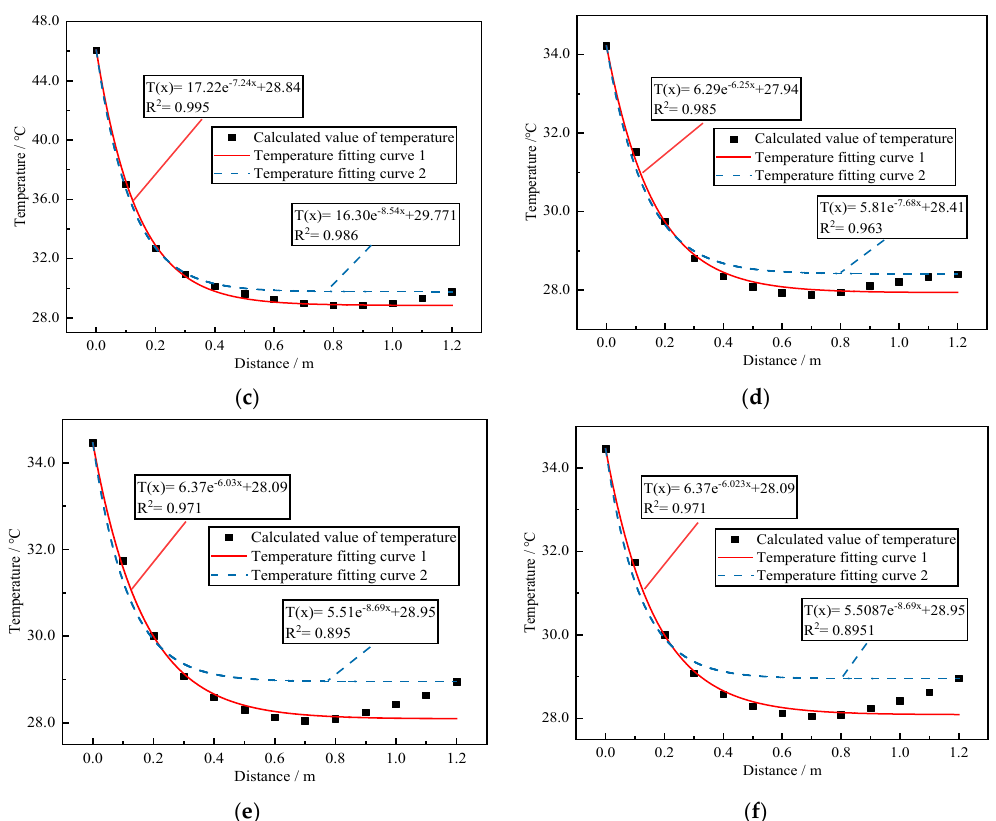
Figure 27. The fitting results of discrete temperature data. ( a ) The east tower wall; ( b ) the south tower wall; ( c ) the west tower wall; ( d ) the north tower wall; ( e ) the inner east tower wall; ( f ) the inner west tower wall. Note: The temperature fitting curve 1 in the figure is the result of fitting the temperature value at 0.8 m from the external surface as the parameter C in Formula (33); the temperature fitting curve 2 is the result of fitting the temperature value of the internal surface as the parameter C in Formula